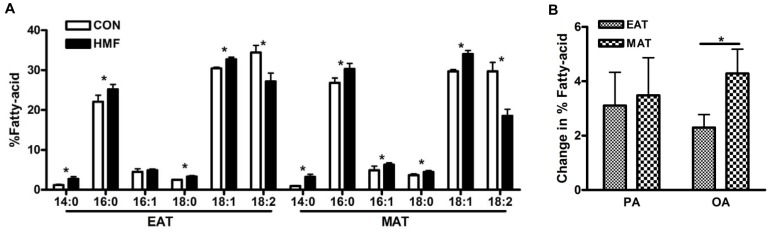
Oleic acid increase is highest in MAT.Mass spectrometry analysis of (A) fatty-acid composition (expressed as a percentage of total fatty acid) in the EAT and MAT following three control or 60% HMF feeding. (B) Change in the percentage of palmitic (PA) and oleic (OA) acid out of total fatty-acids expressed as the difference between control and HMF-fed mice. (N = 5–6).